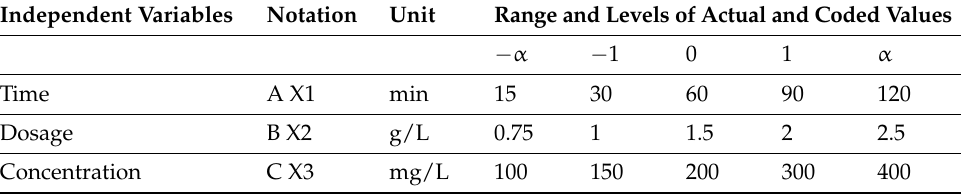
Table 8. Range and levels used for the batch adsorption study. Independent